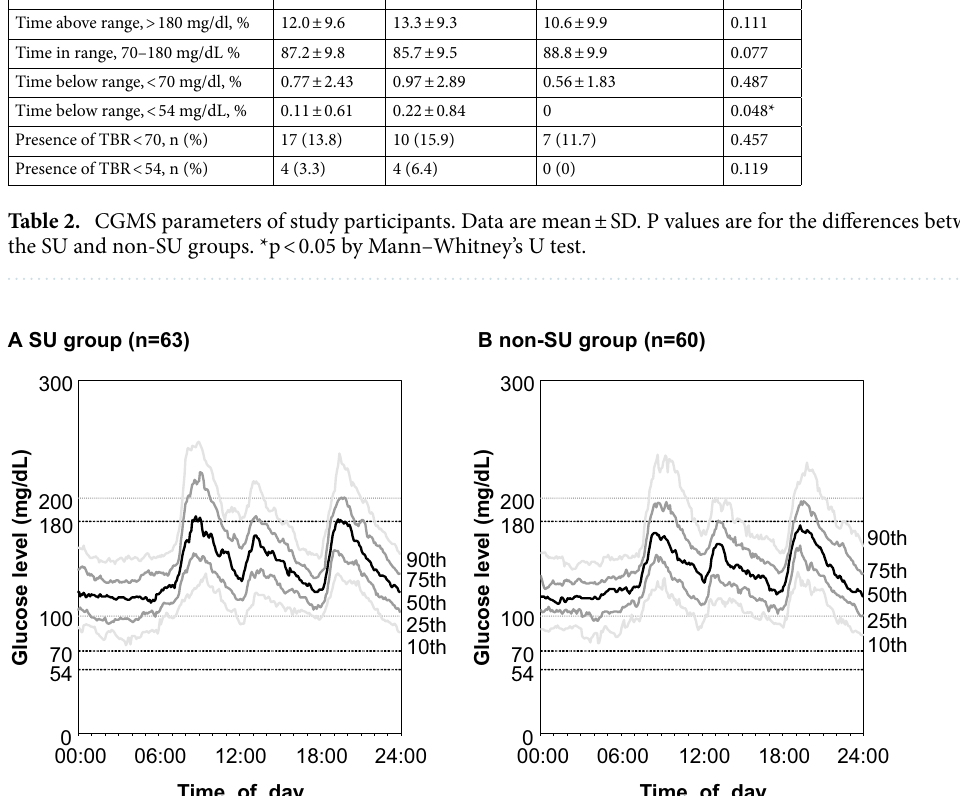
Figure 2. ( a ) The 24-h glycemic profile of 63 patients of the SU therapy group and ( b ) 60 patients of non-SU therapy group. Line charts are the glucose levels were measured by continuous glucose monitoring. The center solid line is the median value, while the two gray solid lines are the interquartile range (25th and 75th percentiles), and the light gray lines represent the 10th and 90th